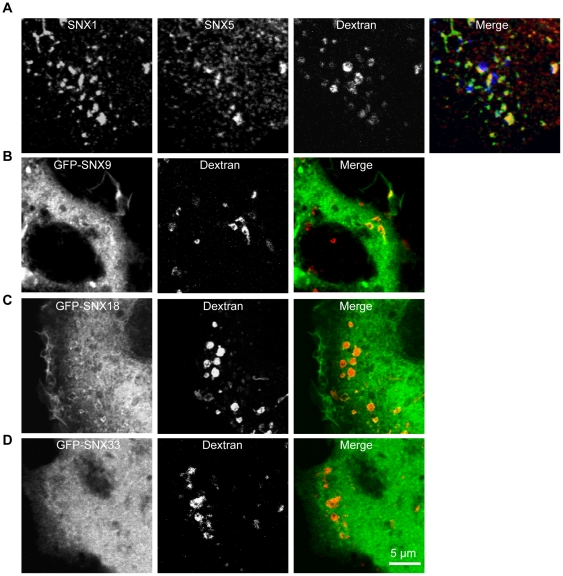
SNX1, SNX5, SNX9 and SNX18 associate with early macropinosomes.A: HEK-Flp-In cells were pulsed with 100 µg/mL dextran (10,000 MW) conjugated to Alexa-647 (dextran-647) for 5 minutes before being transferred to 4°C and washed with 0.45 mM CaCl2 1 mM MgCl2 PBS. The cells were then treated with 80 U/mL Streptolysin O for 5 minutes at 4°C to only permeabilize the plasma membrane before washing in 0.45 mM CaCl2 1 mM MgCl2 PBS and incubating with 37°C PBS for 5 minutes. Following fixation with 4% PFA for 30 minutes at 4°C, cell monolayers are incubated with monoclonal and polyclonal antibodies against SNX1 and SNX5 respectively, followed by Alexa-488-conjugated goat-anti-mouse and Cy3-conjugated goat-anti-rabbit IgG secondary antibodies. B, C, and D: 24 hours post transfection, HEK-Flp-In cells transfected with pEGFP-SNX9 (B), pEGFP-SNX18 (C) and pEGFP-SNX33 (D) were pulsed with dextran-TR for 5 minutes at 37°C prior to fixation at 4°C in 4% PFA. Images were collected on an LSM 510 Meta confocal microscope. Scale bar  = 5 µm.